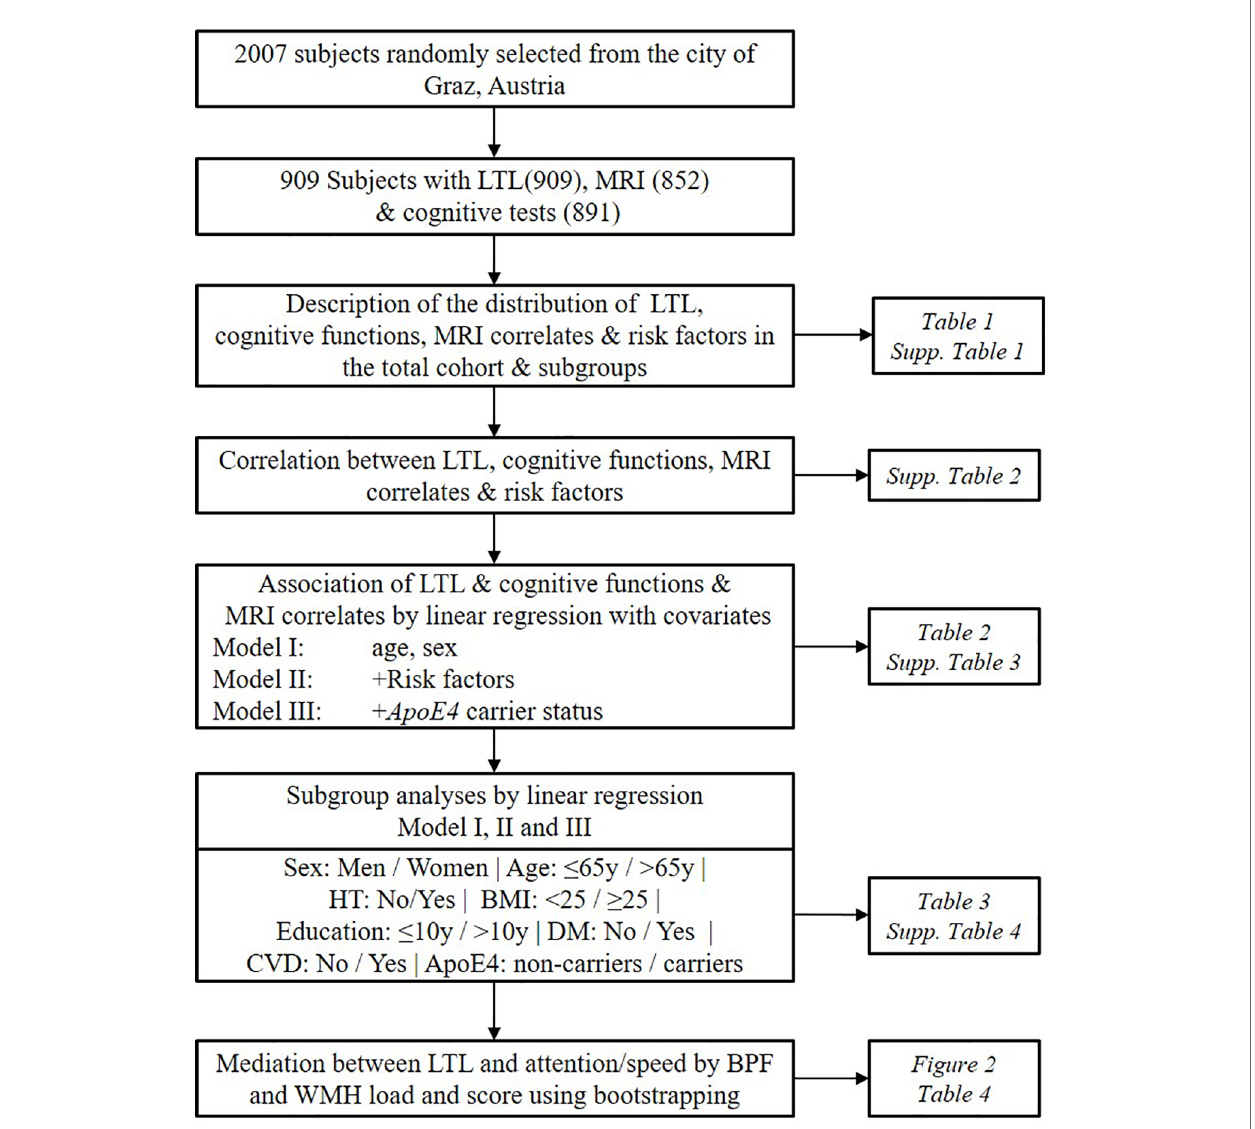
FIGURE 1 | Work fl ow of the study design. The current study cohort is a subsample of the Austrian Stroke Prevention Study. Risk factors include hypertension, diabetes, cardiovascular diseases, body mass index, education, high-density lipoprotein, and smoking status. LTL, Leukocyte Telomere Length; HT, Hypertension; DM, Diabetes Mellitus; CVD, Cardiovascular Disease; BPF, Brain Parenchymal Fraction; WMH, White Matter